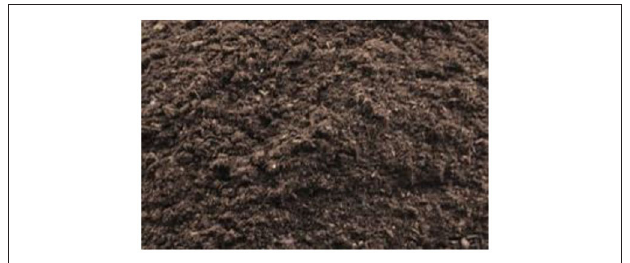
FIGURE 3 | Dried olive wastewater obtained by means of a spray drier system.